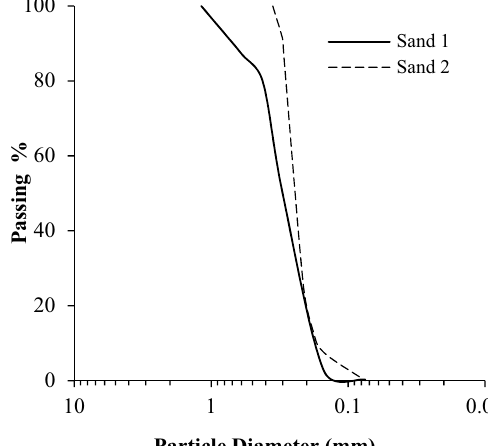
Fig. 3 Sieve analysis for the used